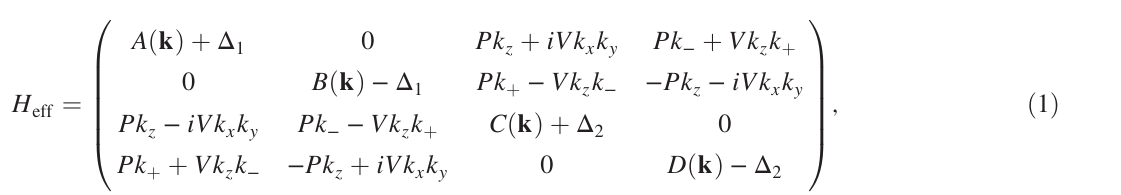
FIG. 5. Calculations for antiferromagnetic configuration of UNiSn. (a) Energy band dispersions along major high-symmetry lines of the Brillouin zone. (b) Enlarged area along the Γ Z direction of the BZ showing the locations of the Weyl points with their coordinates k ¼ ð 0 ; 0 ; 0 . 317 Þ 2 π =a (chiral positive, energy relative to E WP 1 relative to E is − 42 meV). (c) Brillouin zone of the AFM UNiSn with the positions of the Weyl points (magenta refers to positive and F cyan refers to negative chiral